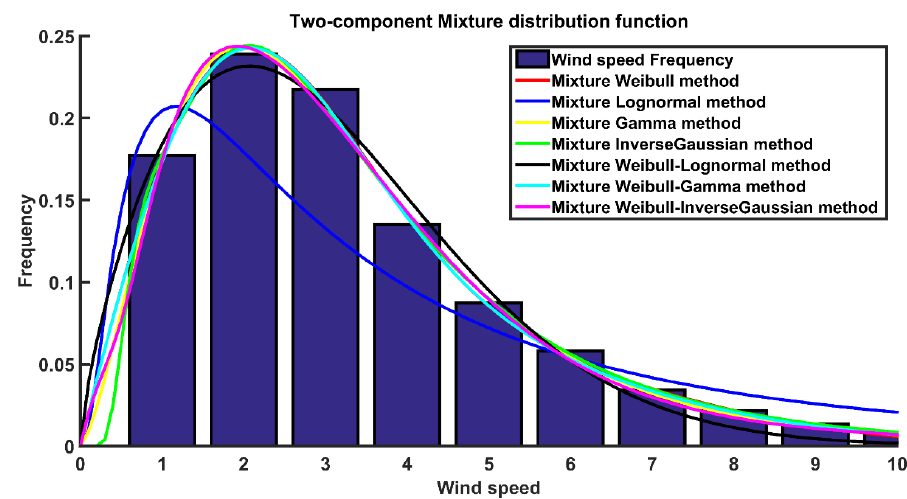
Figure 3. The two-component mixture distribution functions in wind speed modeling.